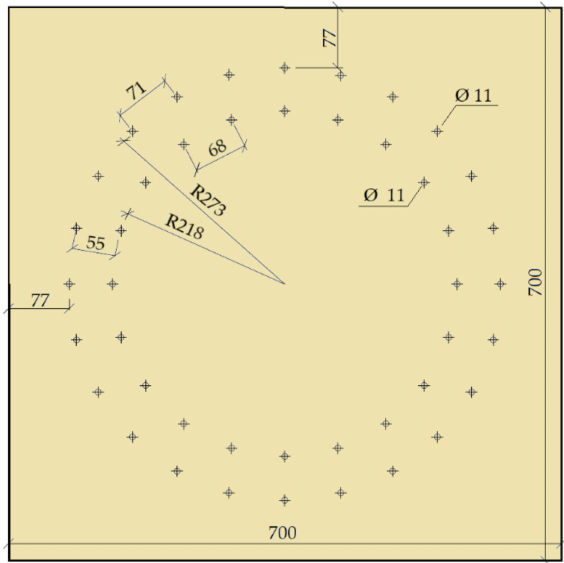
Figure 3. Location of fasteners, and full threaded screws (experiment setup no.